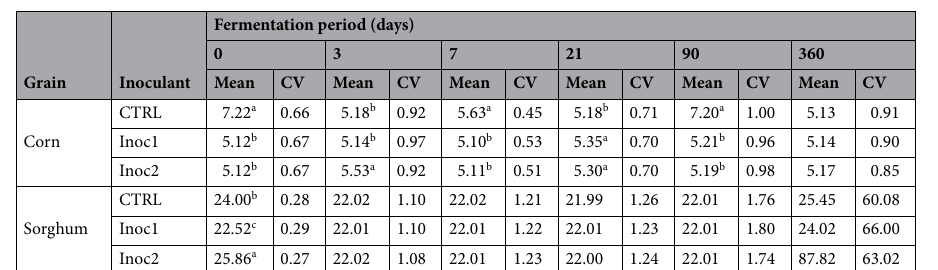
Table 2. Study of inoculants within each fermentation period for the bacterial abundance of ground and rehydrated corn and sorghum grain silages. CTRL non-inoculated, Inoc1 Lactobacillus plantarum and Propionibacterium acidipropionici , Inoc2 Lactobacillus buchneri. a−b Means followed by different letters in the column differ for each combination between inoculant and grain within each fermentation period by credibility interval.